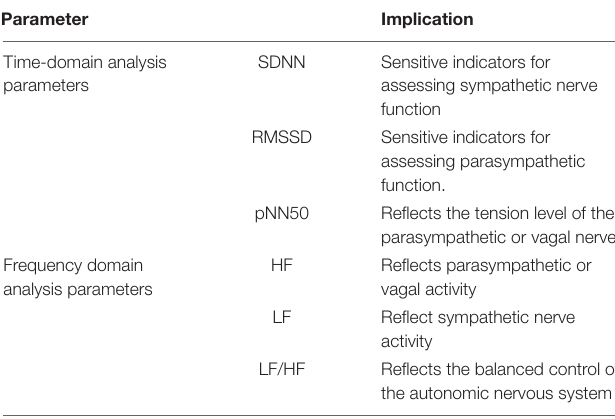
TABLE 2 | Physiological parameters measured by ECG.